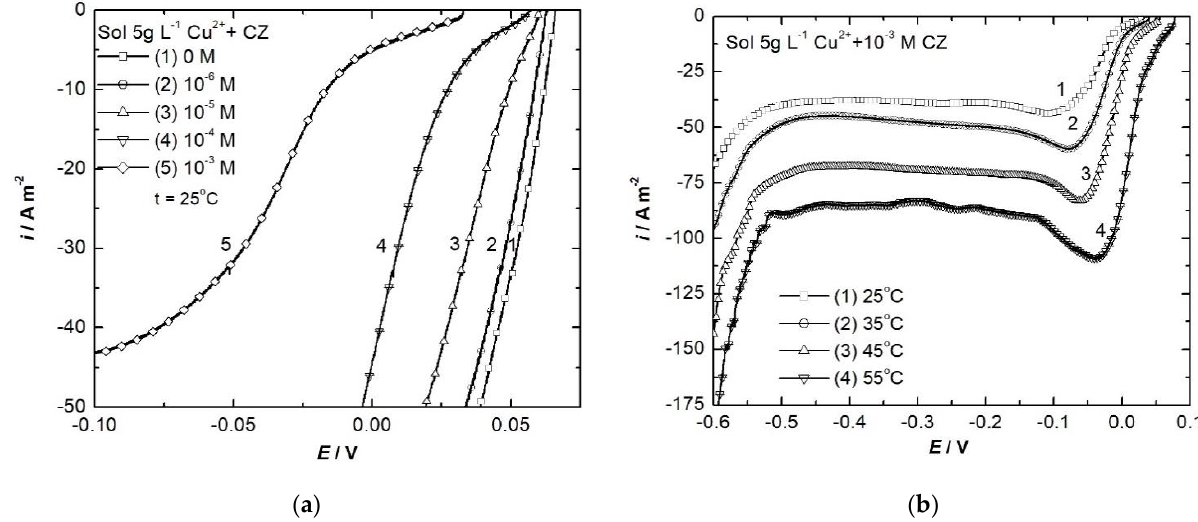
Figure 4. LVs recorded for copper electrodeposition without and with different concentrations of CZ at 25 °C ( a ) and with 10 − 3 mol L − 1 CZ at different temperatures ( b ), 2 mV s − 1 scan rate.